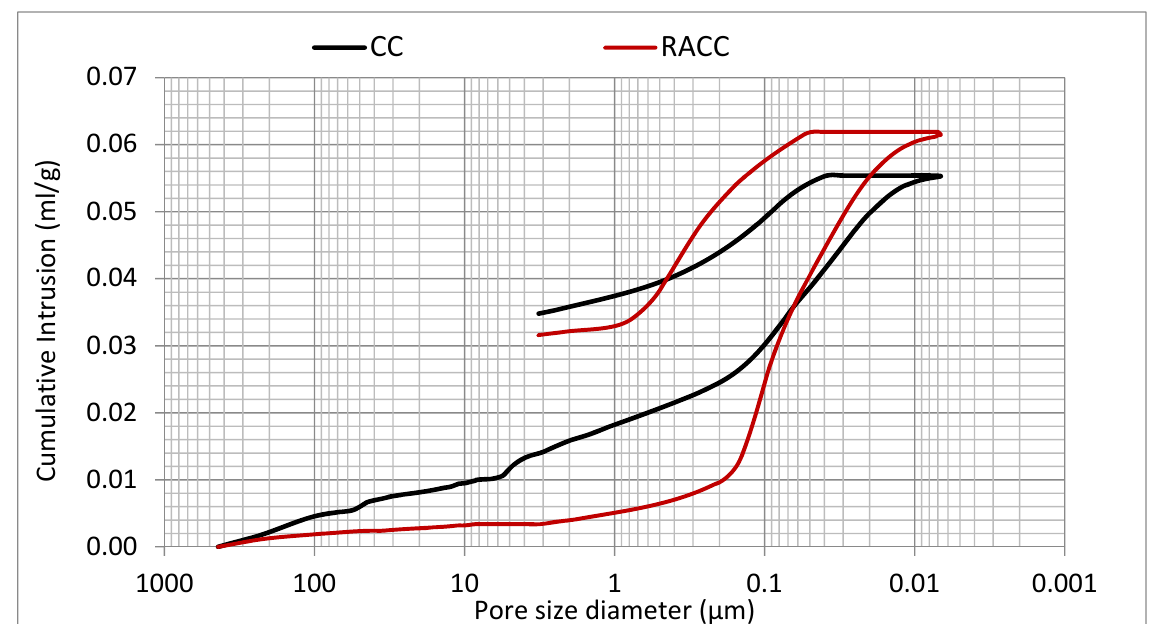
Figure 10. Pore size distribution—Log differential intrusion in 28 d CC and RACC samples.